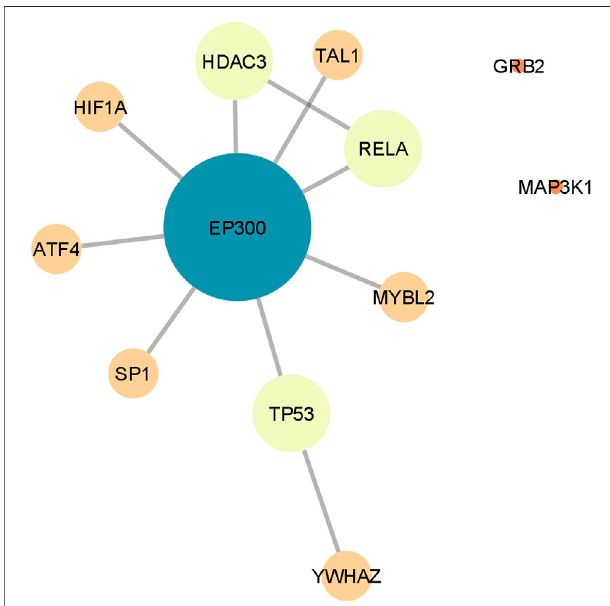
FIGURE 3 | Protein-protein interaction network constructed by merging the networks derived independently for risperidone and olanzapine. Only the genes overlapping the networks of both antipsychotics are shown. Node size and color represent the number of connections (degree) of each gene.